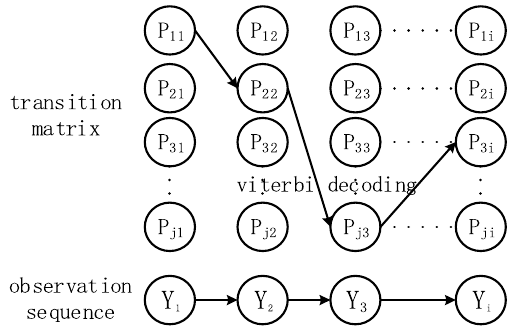
Figure 4. Structure of CRF